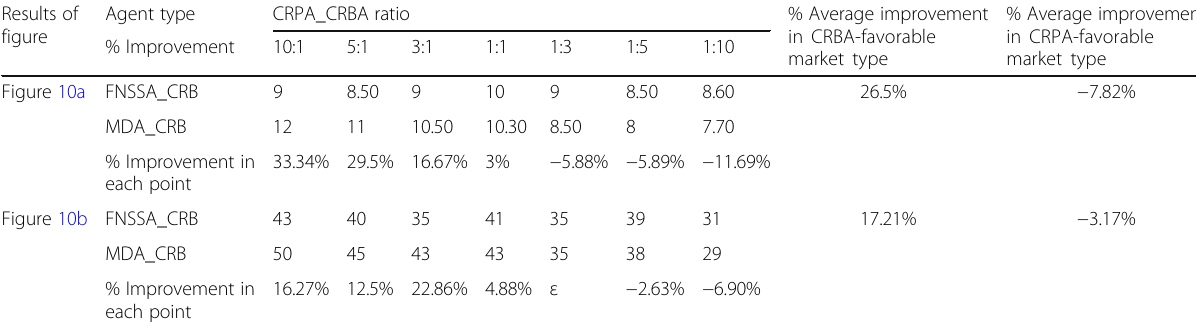
Table 9 Analysis of the results obtained from Fig. 10a-b Results of Agent figure